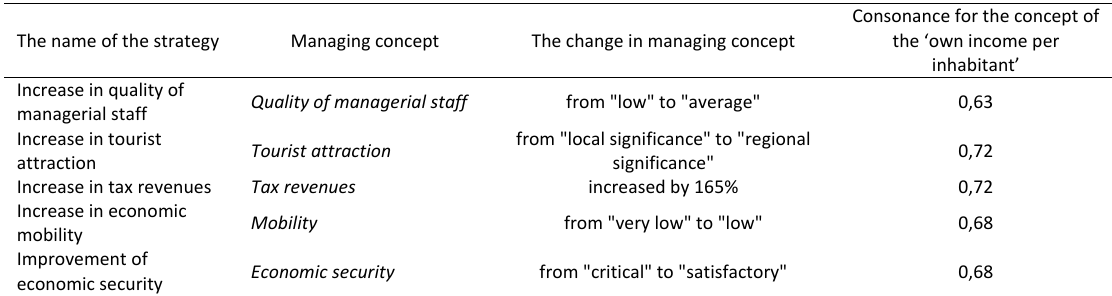
Table 3: Strategies for the growth of the ‘ own income per inhabitant figure’